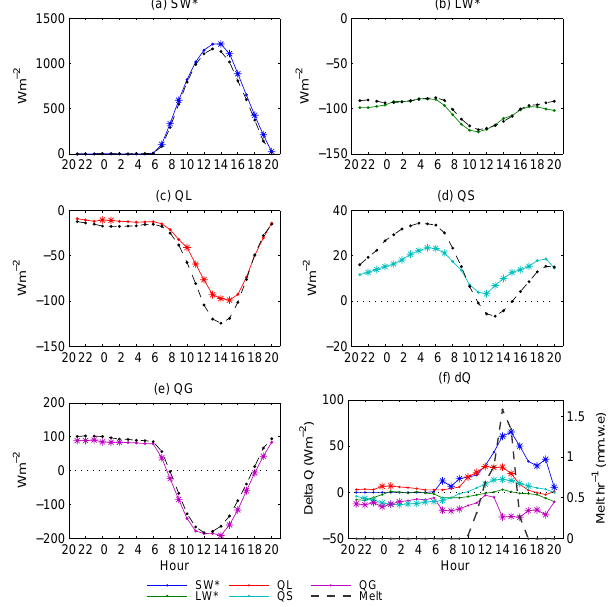
Fig. 6. Mean diurnal cycle of the surface energy fluxes ( Q ) on the upper Guanaco glacier during summer for days with melting (coloured lines) and days without melting (black lines). (a) Net shortwave radiation flux; (b) net longwave radiation flux; (c) tur- bulent latent heat flux; (d) sensible heat flux; (e) total ground heat flux; (f) difference between melt and non-melt days (colour lines, left axis), and mean hourly melting rate (black dotted line, right